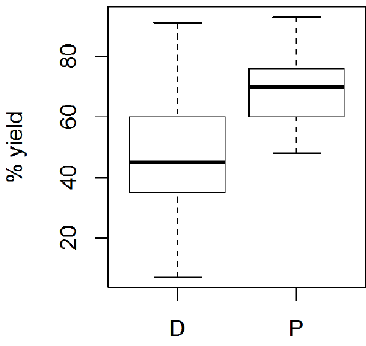
Figure 2. Boxplot of percentage yield for bis(pyrrolyl)squaraine dyes (D) and pyrrole-derived polysquaraines